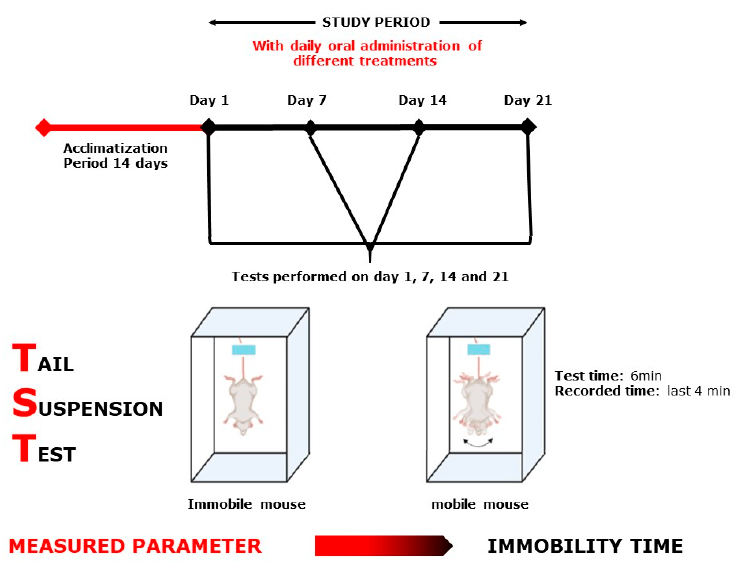
Figure 9. Forced Swimming Test scheme.